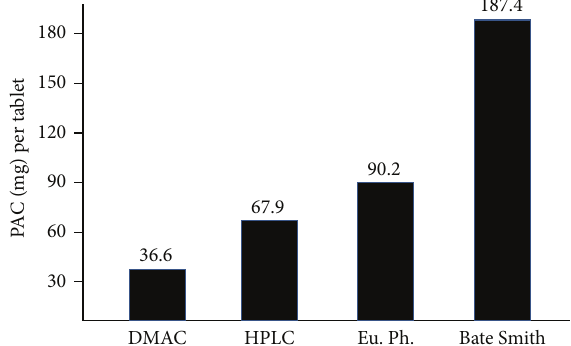
Figure 2: Comparative results of the same cranberry finished